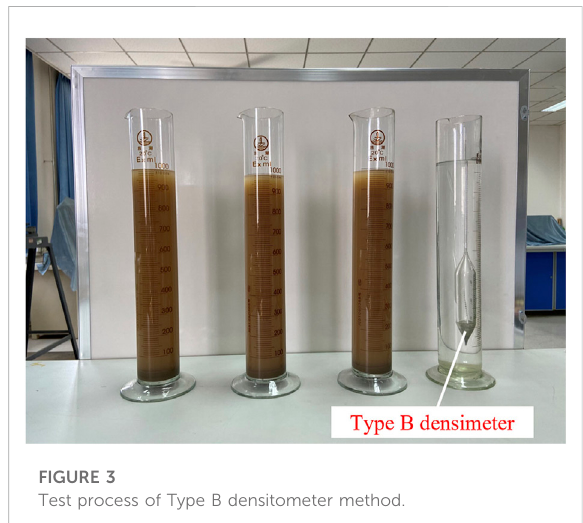
FIGURE 3 Test process of Type B densitometer